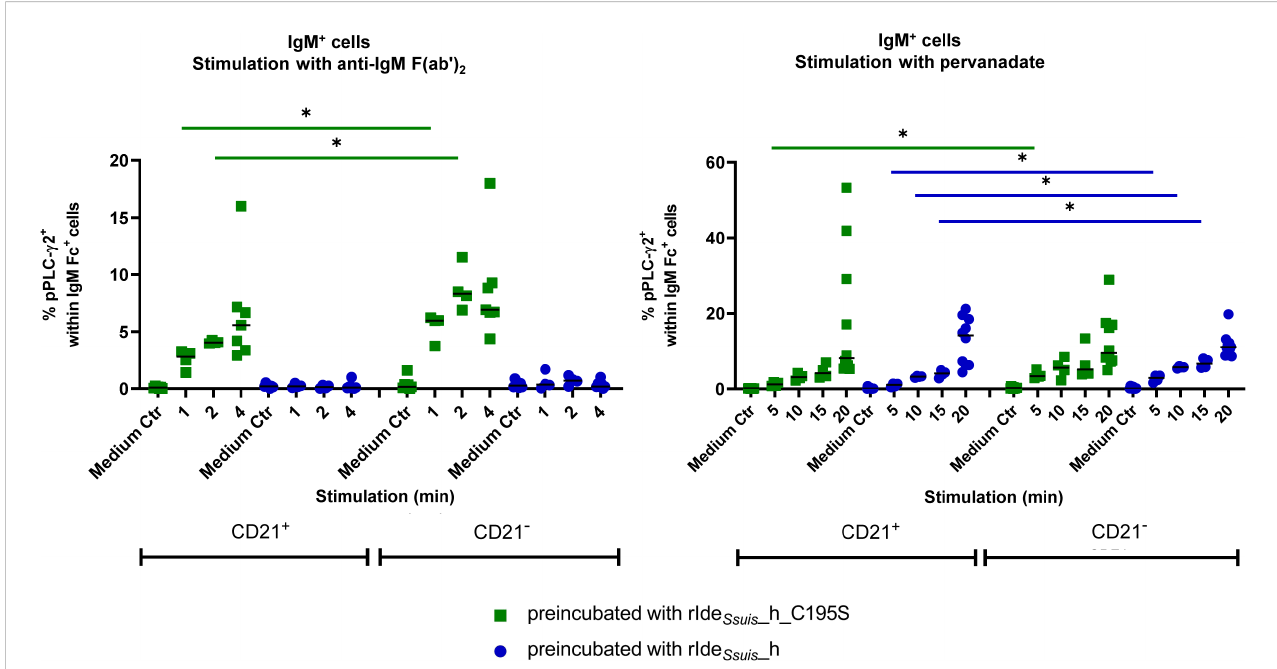
FIGURE 5 Treatment with rIde Ssuis _homologue abolishes IgM B cell receptor mediated signaling in CD21 + B2 cells and CD21 - cells. Porcine PBMC of 7 to 8-week- old piglets (n = 4 - 8) were incubated for 45 min with 4 µg/1x10 6 cells rIde Ssuis _homologue (rIde Ssuis _h) or rIde Ssuis _homologue_C195S (rIde Ssuis _h_C195S). After washing, cells were stimulated with anti-IgM F(ab ’ ) 2 or tyrosine phosphatase inhibitor pervanadate for the indicated times or were kept in cell culture medium without stimulation (Medium Ctr.). Cells were stained and analyzed for IgM Fc, CD21 and phosphorylated PLC- g 2 by fl ow cytometry. Cells with the same treatment were compared with Mann-Whitney test. Bars represent median, signi fi cant differences are indicated (p< 0.1 *). Results of statistical analyses considered not signi fi cant are not shown (p >